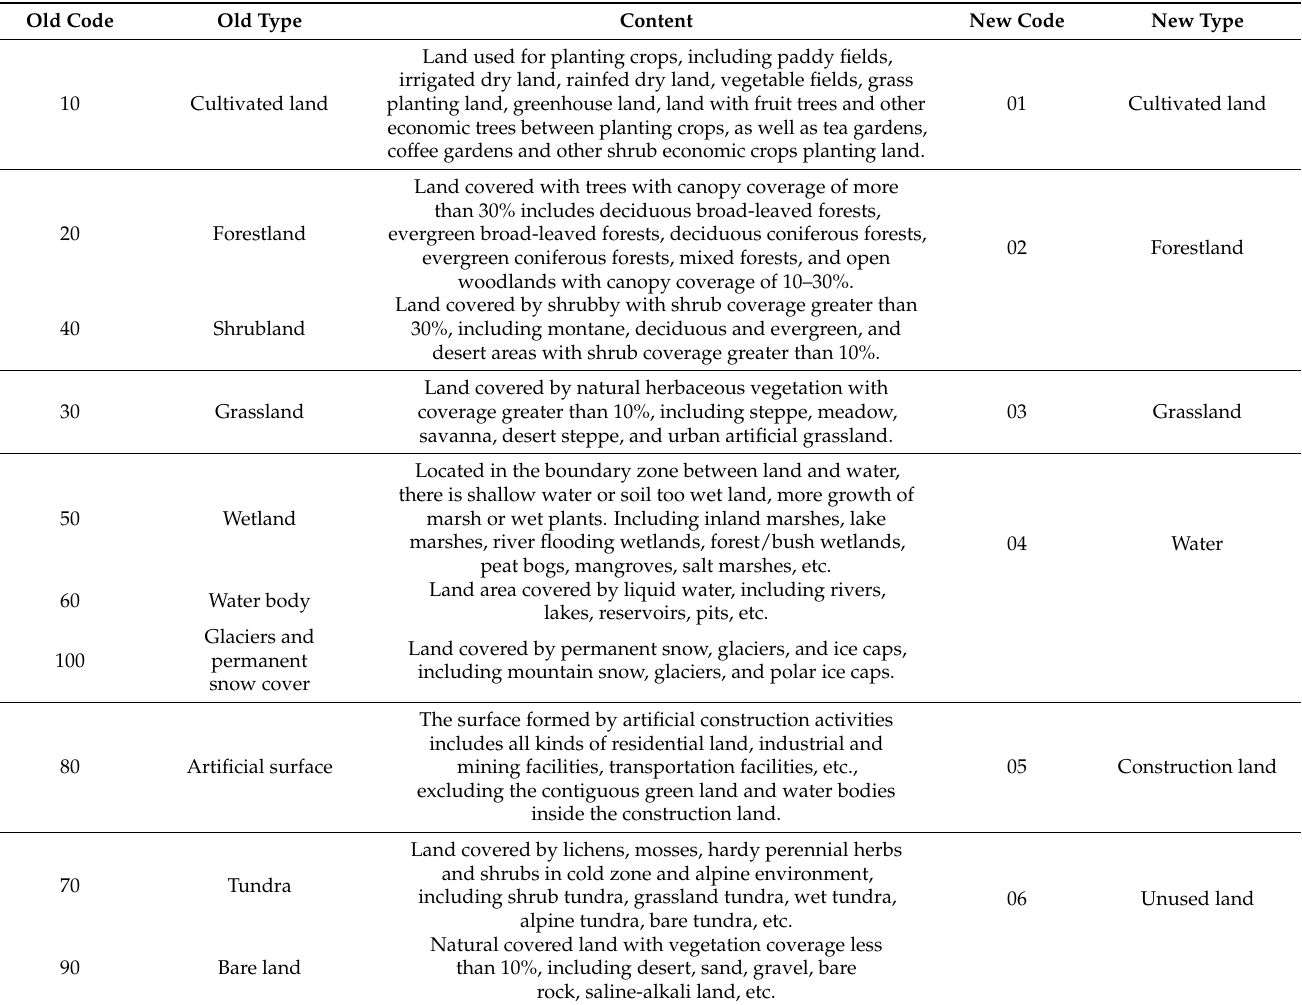
Table A1. Land use type